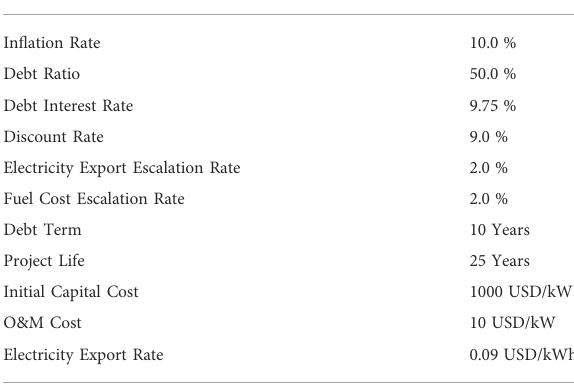
TABLE 7 Input variables considered in fi nancial